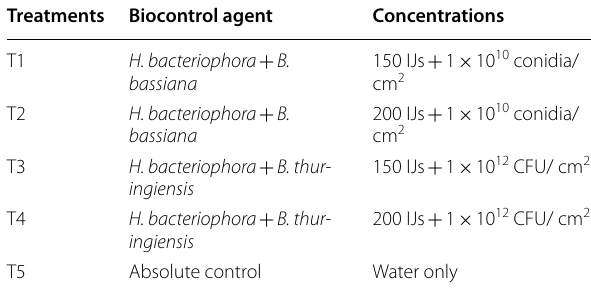
Table 3 Combined